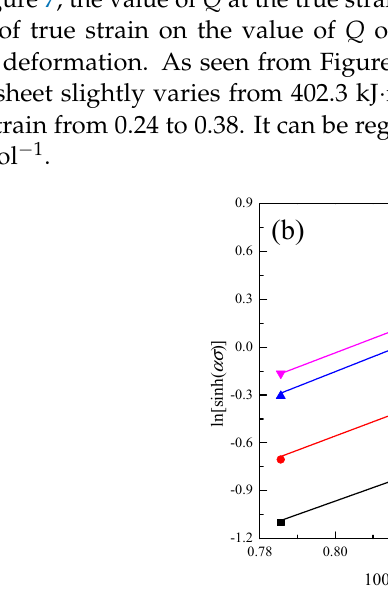
. ε ; ( b ) ln [ sinh ( ασ )] − ( 1000/ T ) at the true strain of